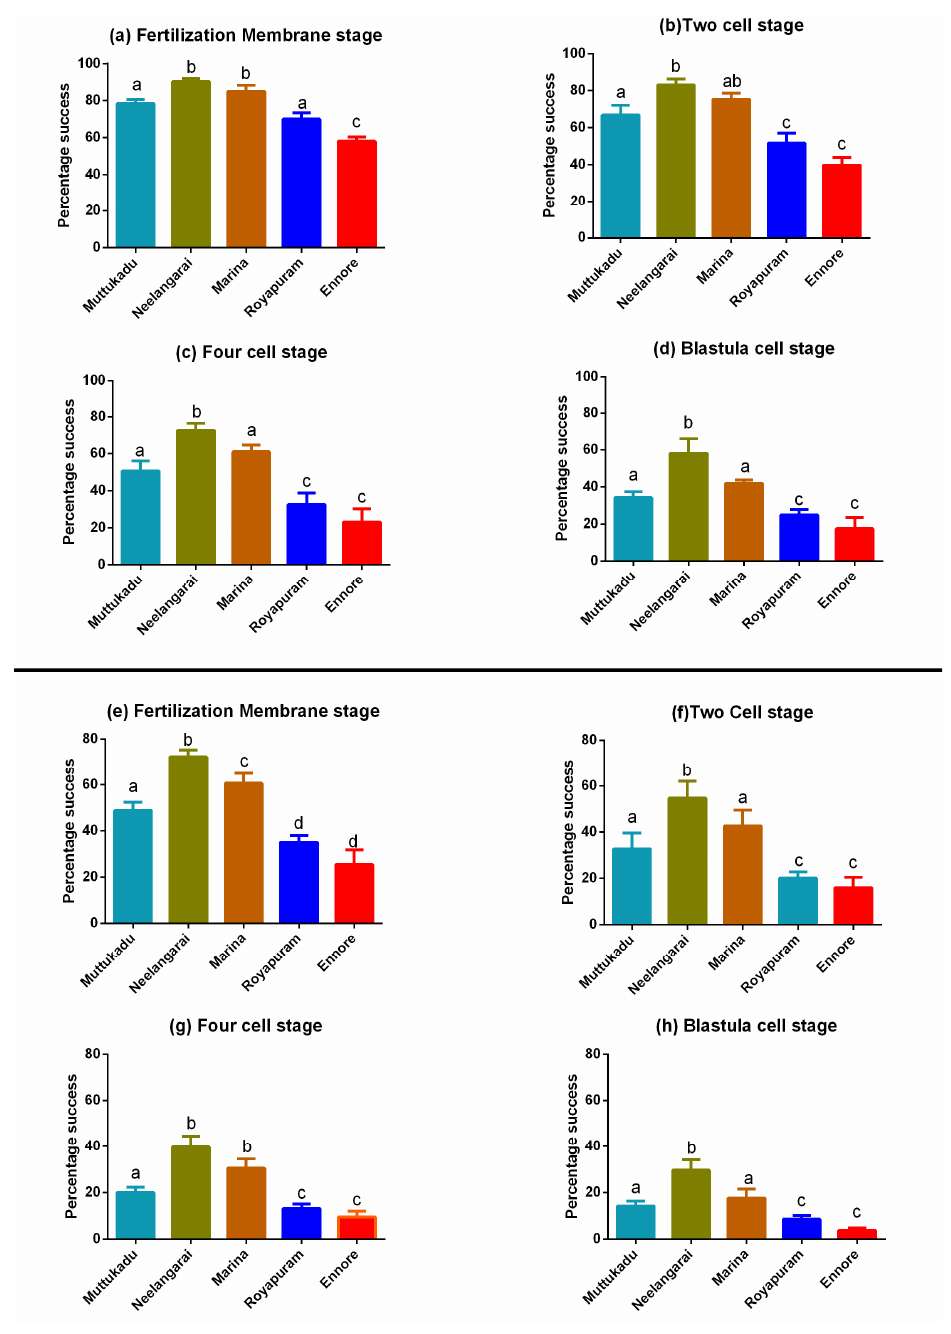
Figure 3. Percent successful development of different embryonic development stages of H. elegans.